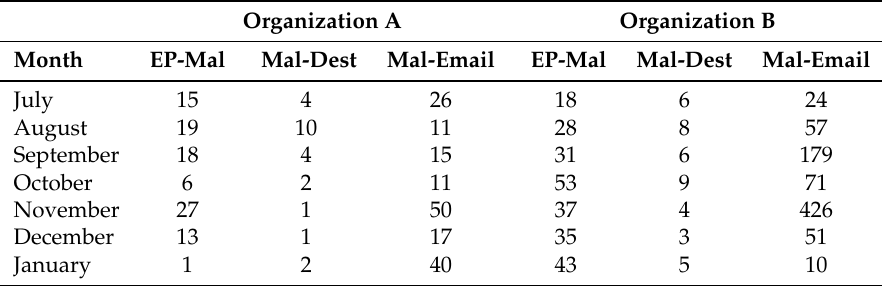
Table 1. Number of Cyber-Events by